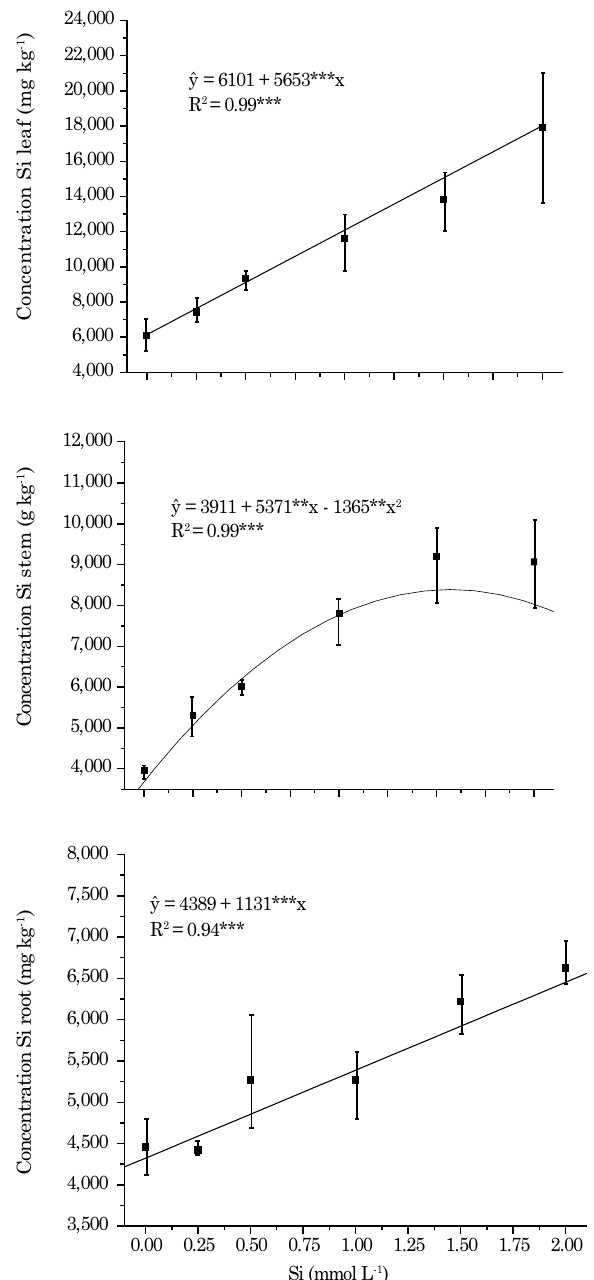
Figure 1. Silicon content in leaves, stems, and roots of maize plants grown in a nutrient solution contaminated by arsenic and under increasing application rates of Si. ** and ***: significant at 1 and 0.1 %).